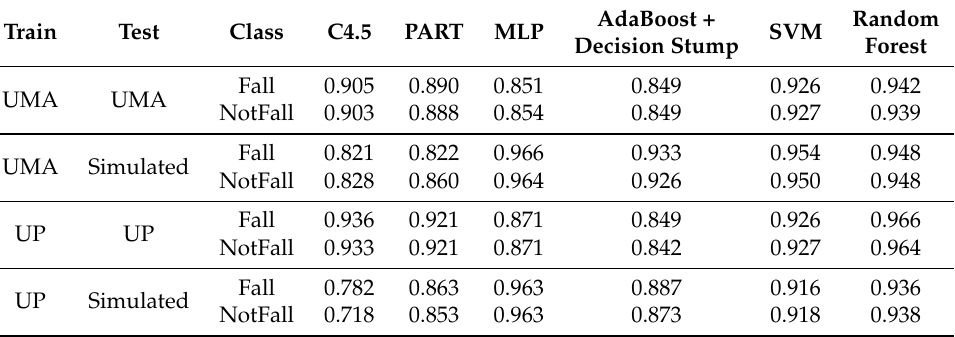
Table 1. F 1 score evaluation for the binary falls classification. The training was executed using datasets from other works while the testing was against our simulated dataset or if against themselves, using cross-validation with ten